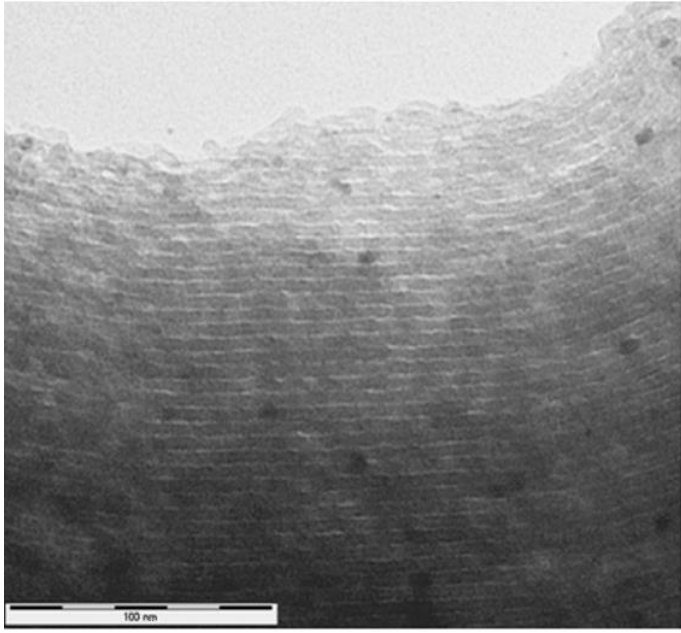
Figure 3. TEM image of the Cu@SBA-15 nanocatalyst.